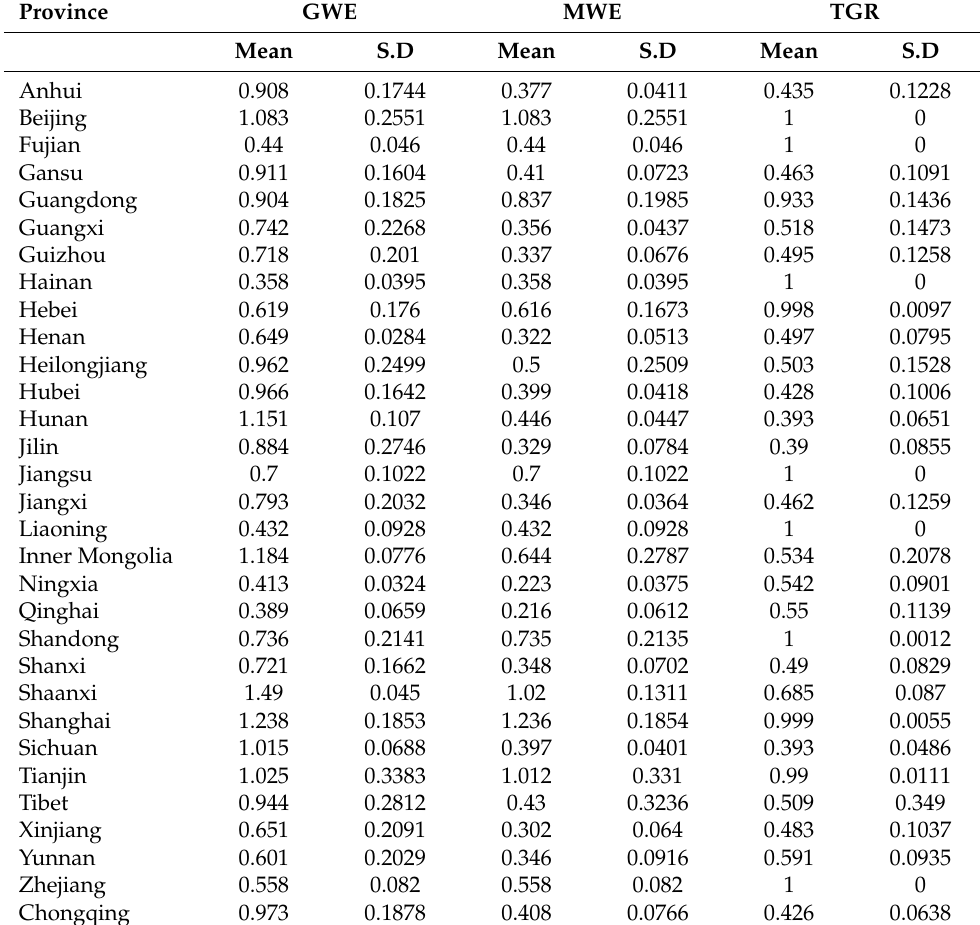
Table 3. Group water efficiency, Meta water efficiency, and TGR in 31 provinces and cities in